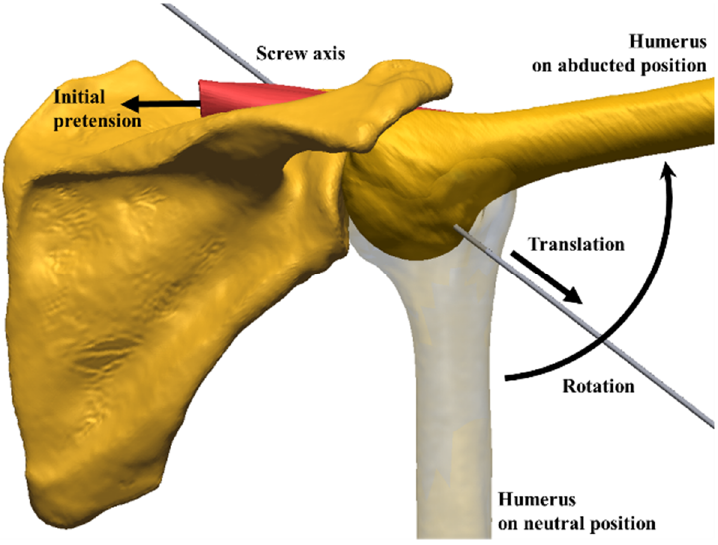
Figure 2. Humeral motion between neutral and abducted position.